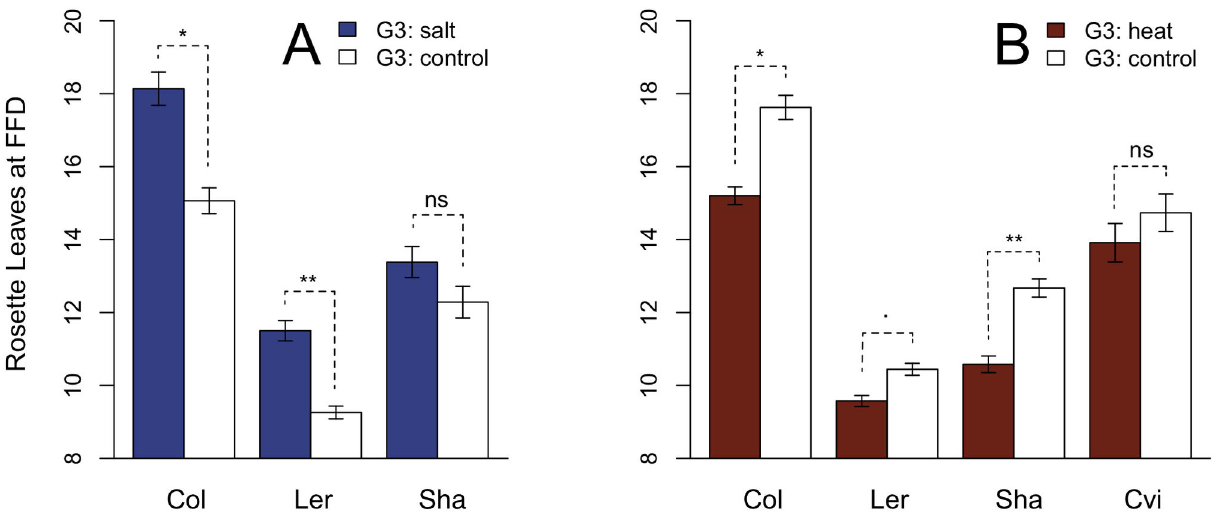
Figure 4. Effect of stress treatments on rosette leaves at FFD. A: Col, Ler and Sha grown in G3 under salt (blue) and control (white) conditions. B: Col, Ler, Sha and Cvi grown in G3 under heat (red) and control (white) conditions. ** P-value < 0.01; * P-value < 0.05, · P value < 0.1, ns: P-value not significant. P-values were adjusted for multiple testing according to Benjamini and Hochberg [43].